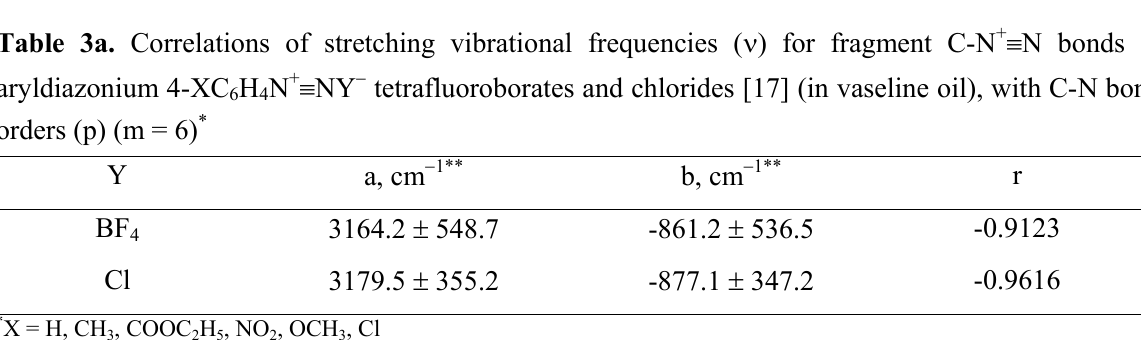
Table 3a. Correlations of stretching vibrational frequencies ( ν ) for fragment C-N + ≡ N bonds in